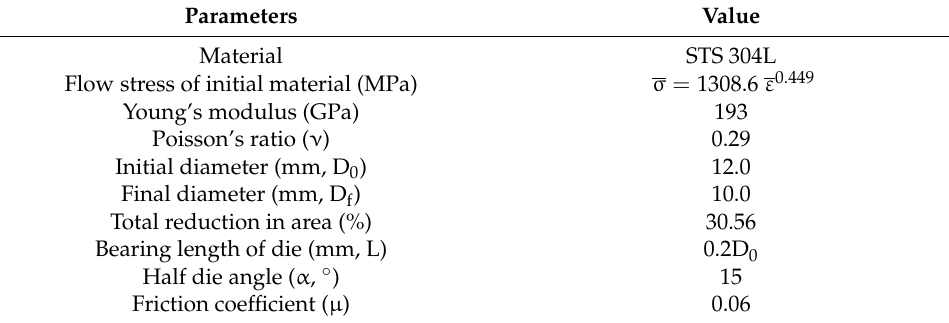
Figure 3. Finite Element (FE) model for drawing process with MRD. Table 1. Input parameters required for the drawing